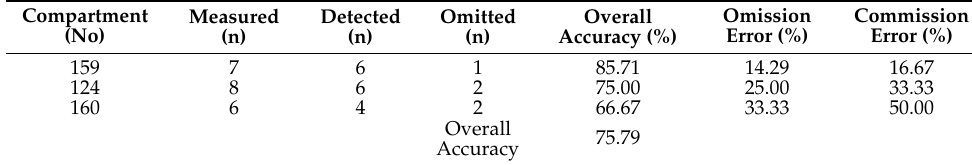
Table 5. Error matrix for stump detection by using integrated TM and